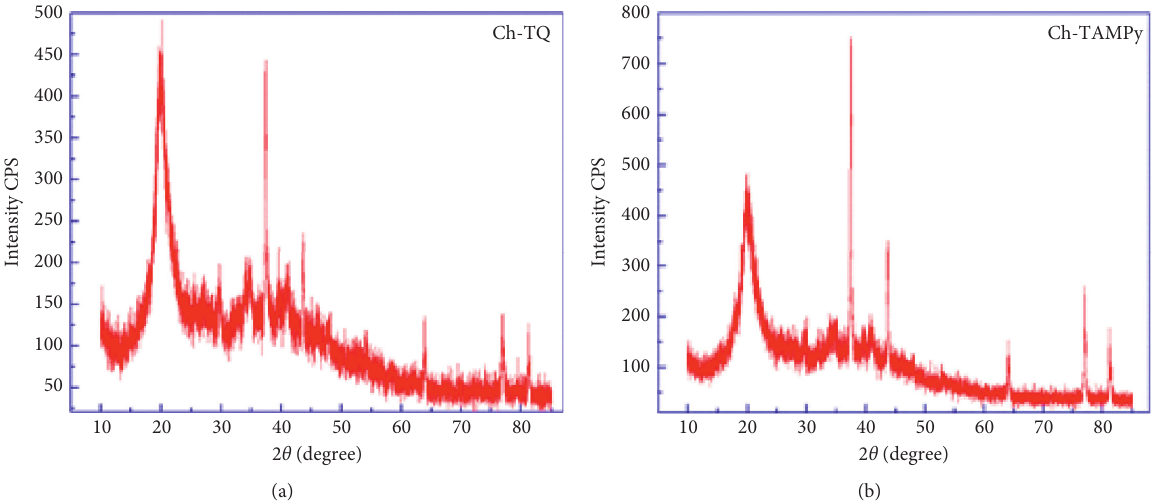
Figure 3: (a) X-ray diffraction pattern of the silver nanoparticles produced by employing Ch-TQ; (b) X-ray diffraction pattern of the silver nanoparticles produced by employing Ch-TAMPy.